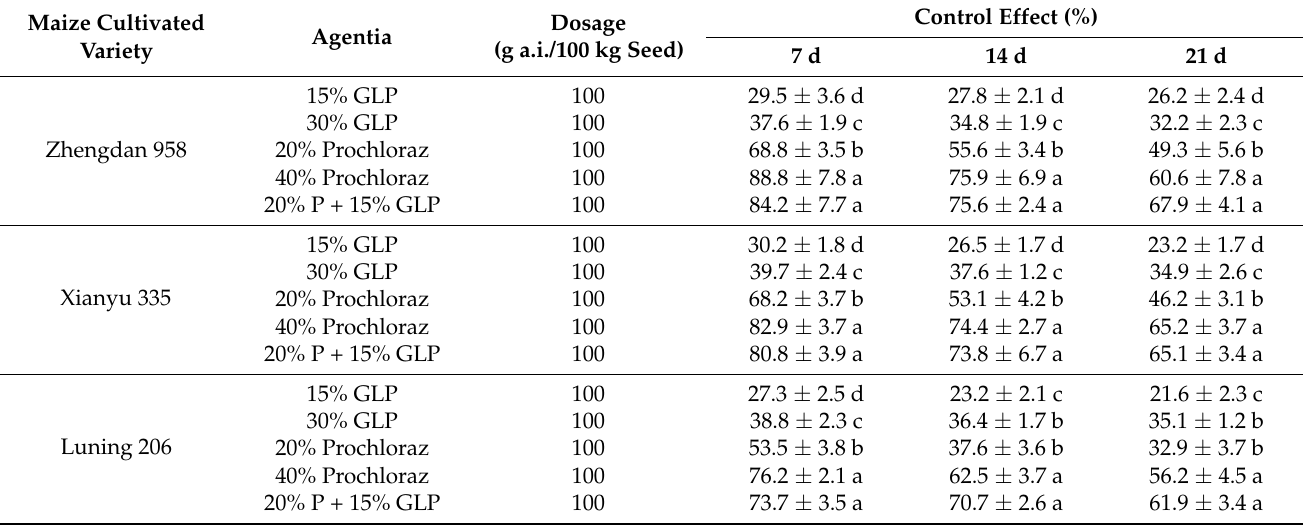
Table 11. Control effect of seed treatment on maize stalk